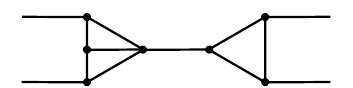
Figure 1 . A 1-particle reducible 3-loop topology. The line in the middle must correspond to one of the standard tree-level seesaw mediators, hence the topology is not genuine. The middle line is a fermion with the quantum numbers of (cid:23) R (cid:17) ( 1 ; 1 ; 0) or (cid:6) (cid:17) ( 1 ; 3 ; 0) if it splits the external (cid:12)elds as LH j LH , or it is the scalar (cid:1) = ( 1 ; 3 ; (cid:0) 1) if the splitting is LL j HH .